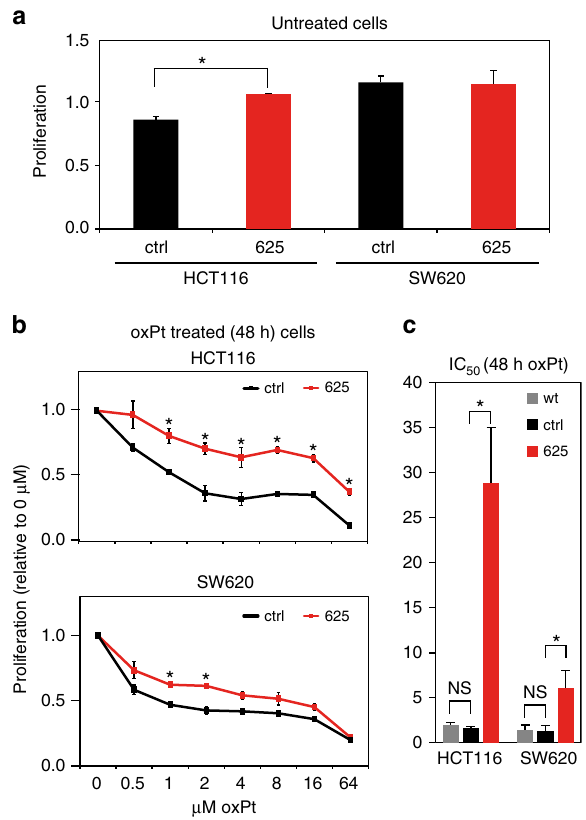
Figure 1 | Ectopic expression of miR-625-3p is associated with increased viability in oxPt medium. ( a ) Cell proliferation upon DOX induction of miR-625-3p in the CRC cell lines HCT116.625, SW620.625 and control cells expressing a scrambled shRNA was determined by an MTTassay after 72h of growth. Displayed as mean ± s.e.m. ( n ¼ 3). ( b ) Cell proliferation after 48h of oxPt treatment was assessed by MTT in DOX-induced HCT116.625, SW620.625. Displayed relative to untreated cells as mean ± s.e.m. ( n ¼ 3). ( c ) IC 50 values were calculated on the basis of experiments from b as well as from wild-type cells not subjected to pSBInducer